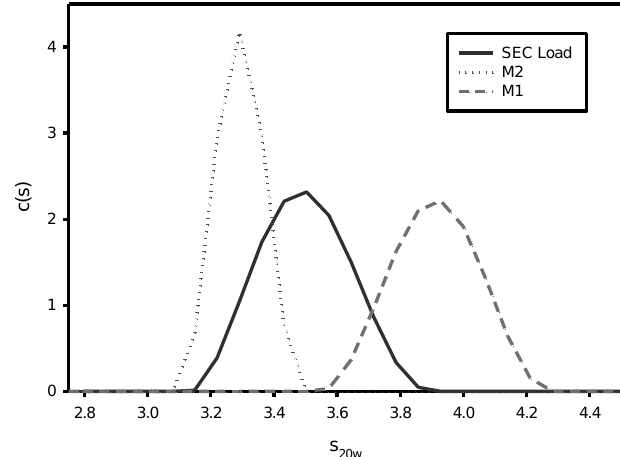
Figure 2. Analytical ultracentrifugation (AUC) analysis of Main 1 vs. Main 2. Fractions from SE chromatography were collected and analyzed by AUC. Fractions corresponding to Main 1 (dashed line) and Main 2 (dotted line) show significantly different sedimentation coefficients. The black trace is from a sample of the load material for the SE-HPLC run. Table 1. % Main 1, Main 2, high molecular mass species (HMMS), and hapten load for samples with varying sNHS/EDC ratios. CGE, Capillary Gel Electrophoresis.